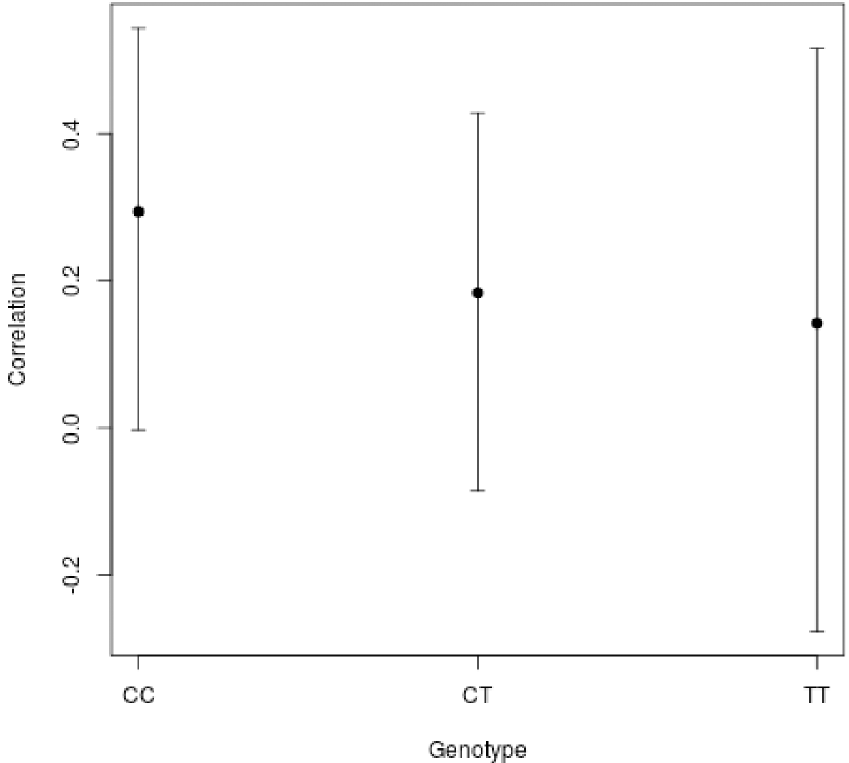
Fig 3. Correlation between serum sCD14 levels and mCD14 expression in individuals with C/C, C/T and T/T CD14(-159C/T) genotypes.